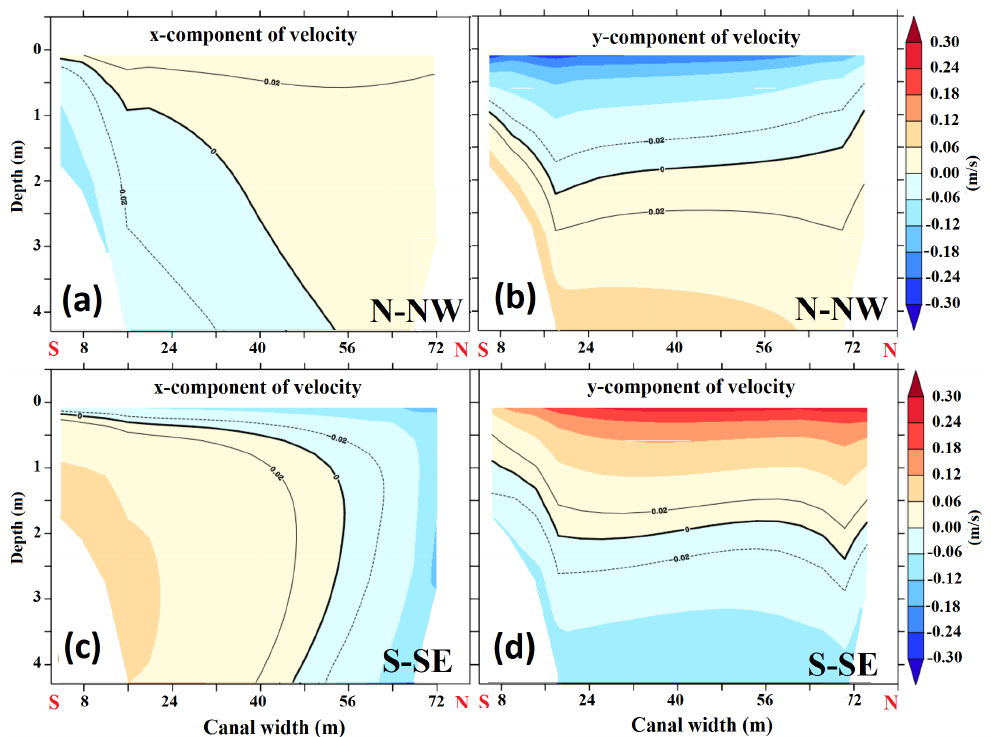
Figure 4. Example of the x- and y-components of velocity fields (u, v) in a transverse section of the Rove Canal, during the wind period (t = 4 h) with the wind speed of 15 m/s, and for Q 1 = 0; ( a ) x-component for N-NW wind; ( b ) y-component for N-NW wind; ( c ) x-component for S-SE wind; ( d ) y component for S-SE